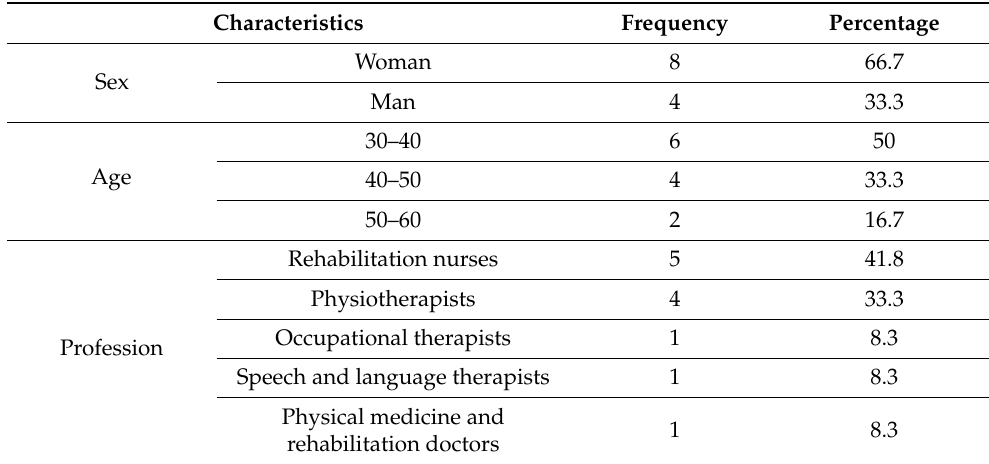
Table 1. Characteristics of the participants.